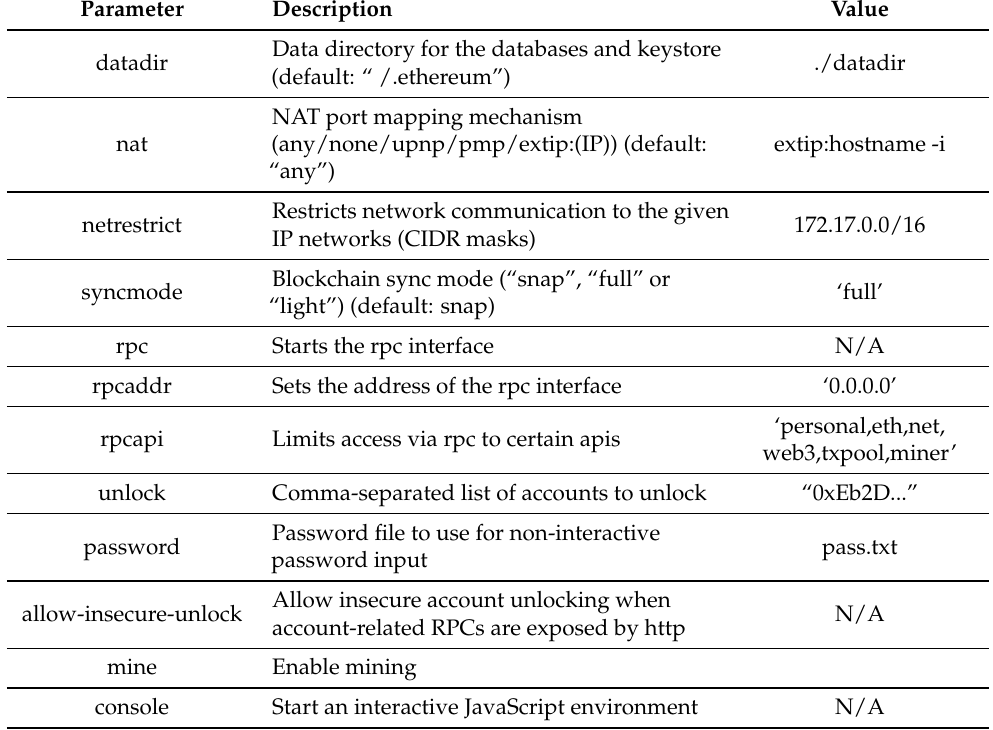
Table 1. Ethereum main node configuration parameters.